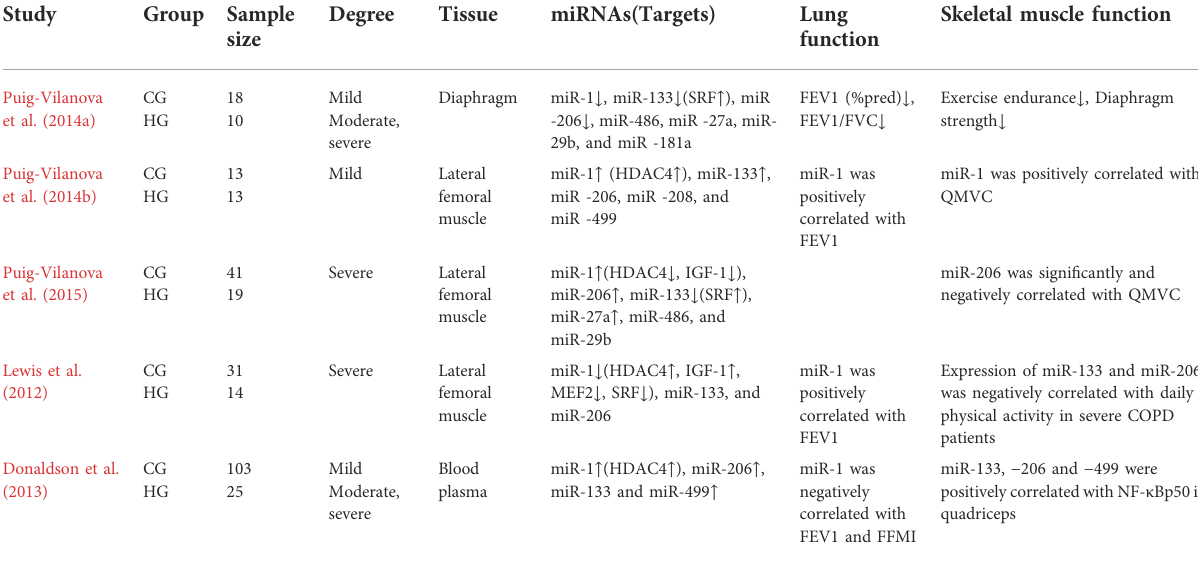
TABLE 1 Differential myomiR expression in COPD compared to healthy